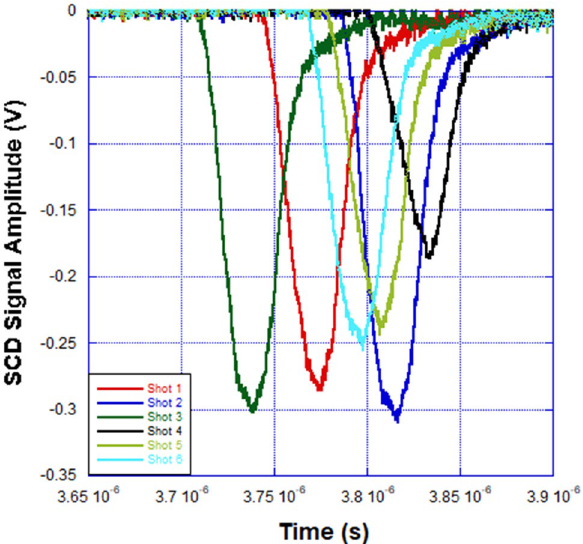
Figure 6. SCD signal amplitude versus time for a series of six shots on the HERMES III pulsed power accelerator. The average signal amplitude and pulse width (excluding shot #4) were -280.67 mV and 31.64 ns